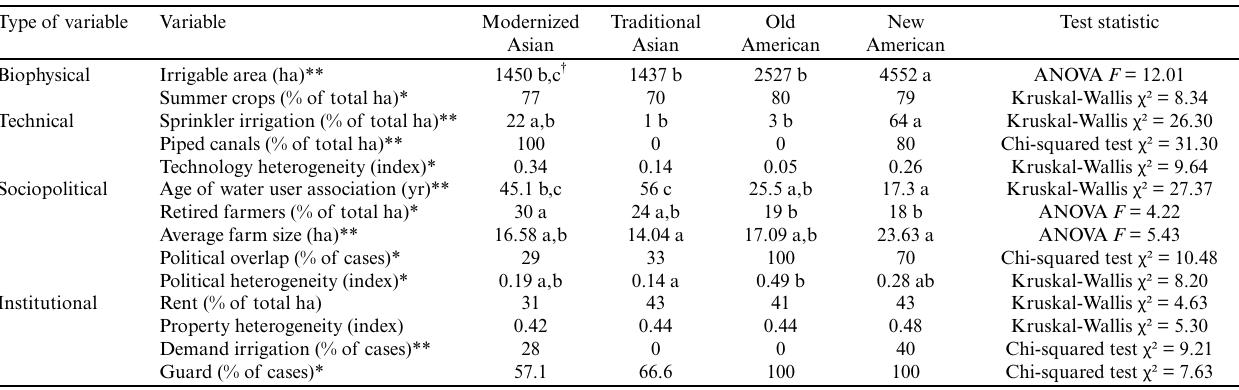
Table 1. Characterization of the main archetypes of irrigation systems obtained through hierarchical cluster